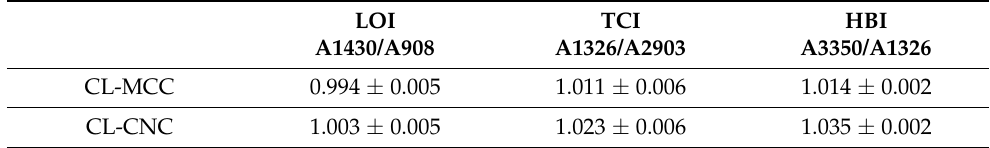
Table 3. Lateral order index (LOI), total crystallinity index (TCI), and hydrogen bonding index (HBI) of the samples CL-MCC and CL-CNC produced from C. linum .